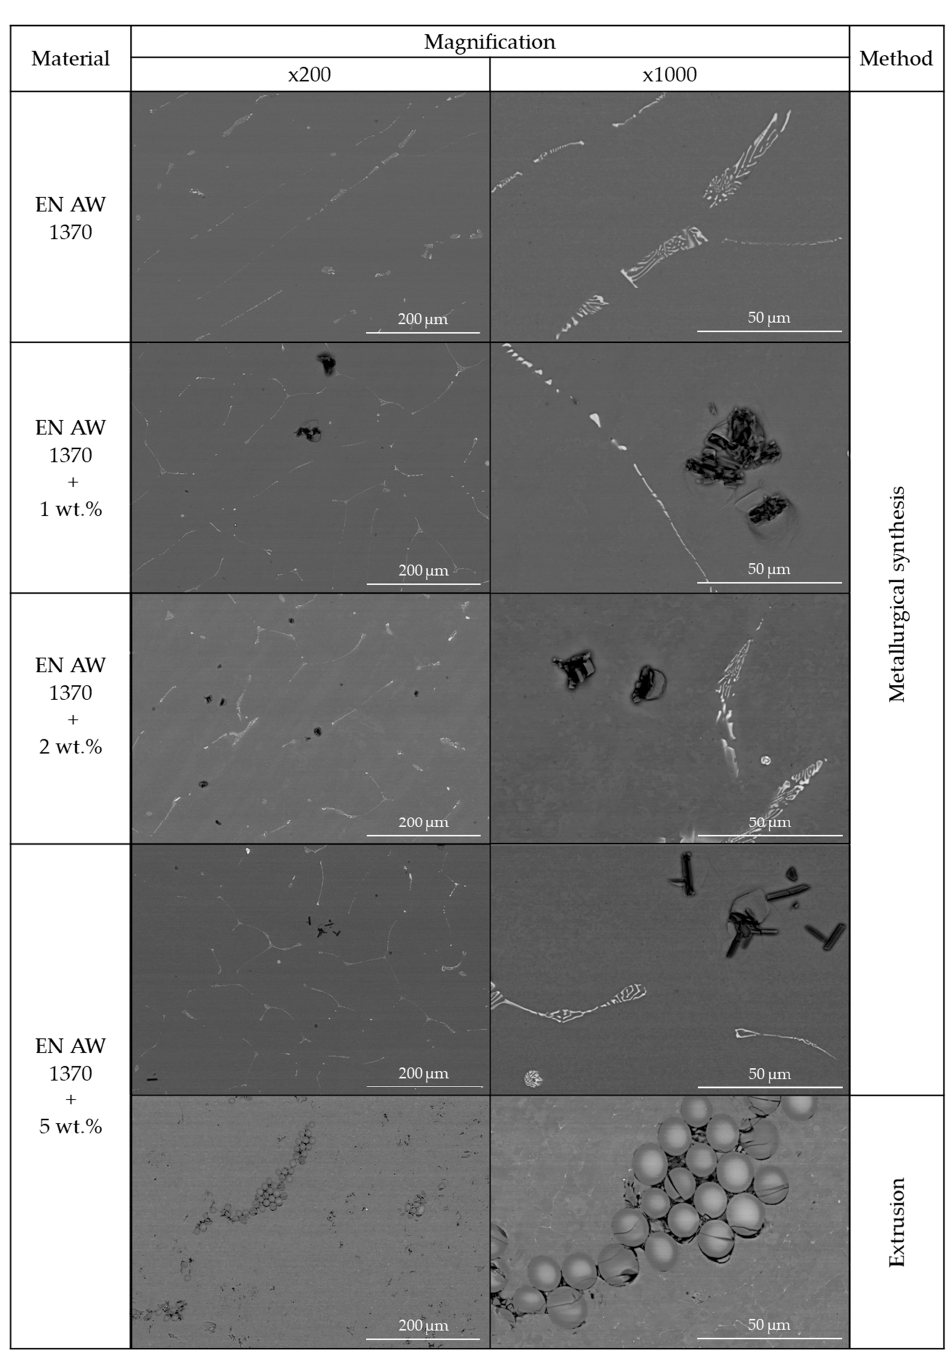
Figure 2. Cross-section of aluminium-glass fibre (Al-GF) composites obtained by metallurgical synthesis and plastic consolidation of metallic powders in extrusion process with various content of GF. Scanning electron microscope, magnification: × 200 and ×